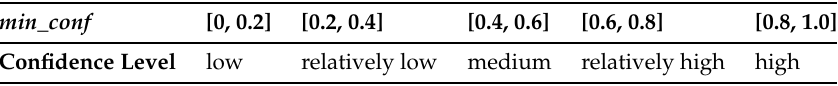
Table 4. Correspondence Table of min_conf Value and Confidence Level.